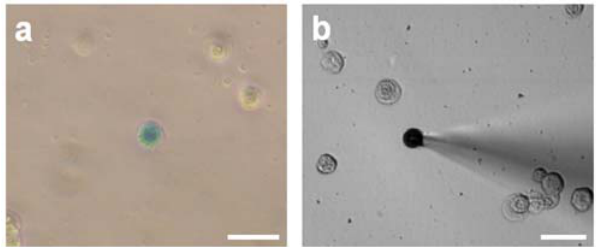
Figure 2. Identification of transfected MCs from rat footpads for electrophysiological analyses. The epidermis of a rat footpad was stripped off of the dermis and the cells were dissociated and transfected with pMath1- b -galactosidase in order to permit detection of MCs (a). Transfected MCs represented 1.35% ( + / 2 0.73) of the epidermal cells. Electrophysiological recordings targeting blue cells were performed in the cell-attached macro-patch configuration (b). Scale bars: 20 m m.